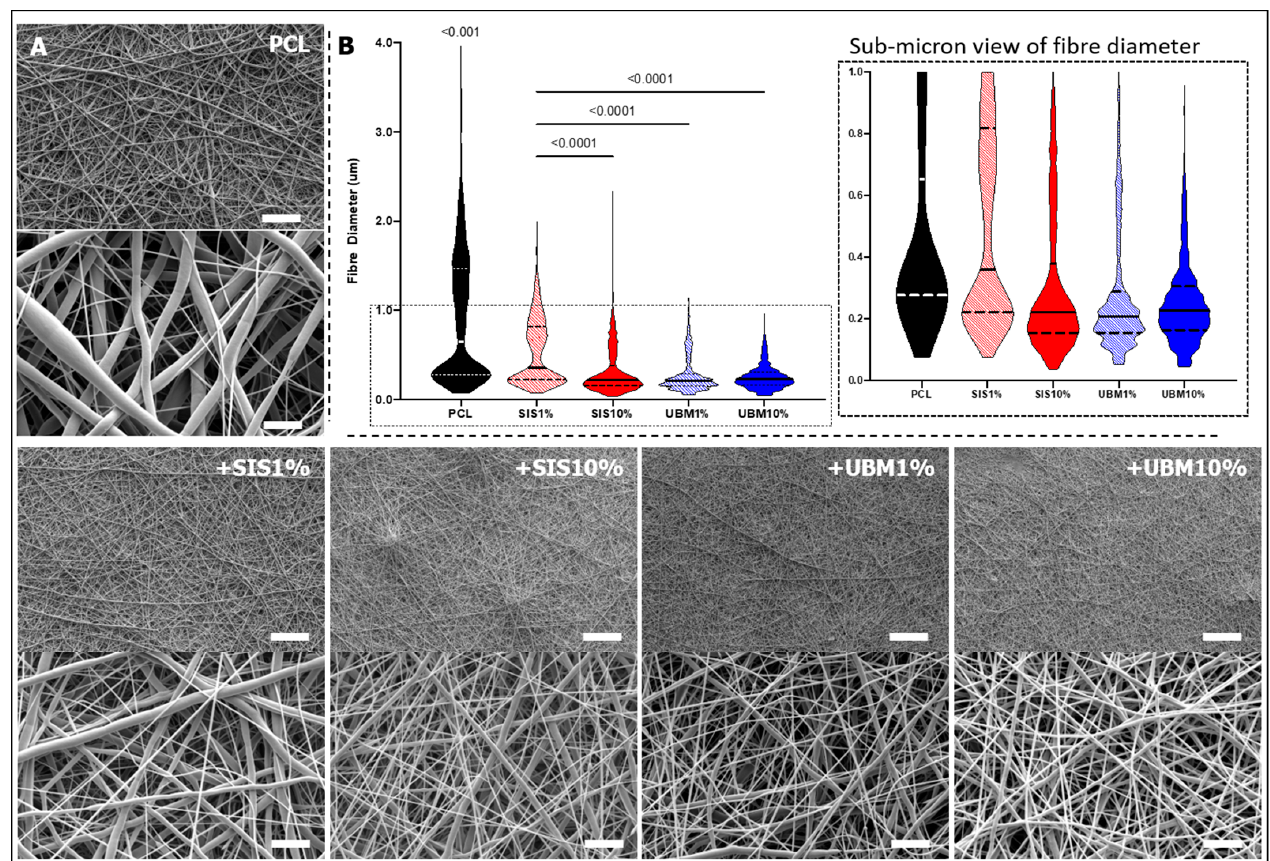
Figure 4. ( A ) Scanning electron microscopy images of electrospun poly( ε -caprolactone) (PCL) scaffolds and following the addition of 1% or 10% decellularised tissue powder (small intestinal submucosa (SIS) and urinary bladder matrix (UBM)). Low magnification images ×1000, scale = 50 µm; high magnification images x10,000, scale = 5 µm. ( B ) Measured fibre diameter presented as a violin plot for each group with magnified view of data spread within the sub-micron range ( n = 900). Kruskal–Wallis statistical test with Dunn’s multiple comparisons ( p < 0.05). PCL was significantly different in all groups.